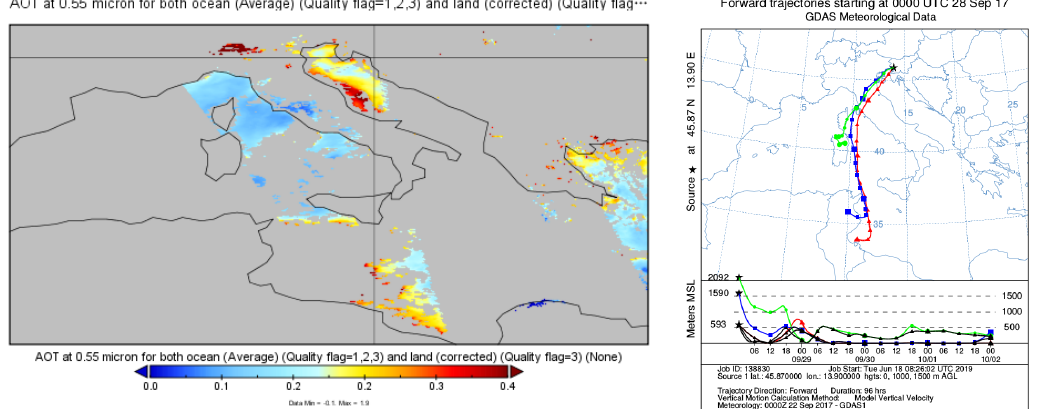
Figure 12. Land and ocean AOTproduct from the MODIS image of Southern Europe (including Vipava Valley) at 11:30 UTC on 28 September 2017 (left) and HYSPLIT modeled 96h backward trajectories arriving over Vipava Valley at 00:00 CET (UTC+1) on 8 September 2017 (right). Both support the presence of aerosols from North Africa in the lower troposphere above the Vipava